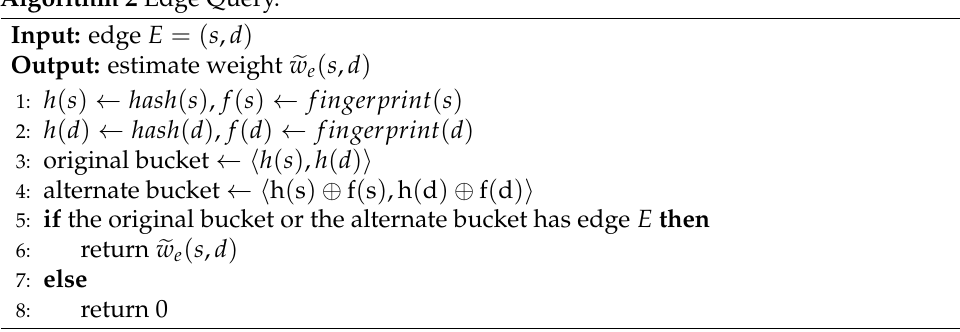
Algorithm 2 Edge